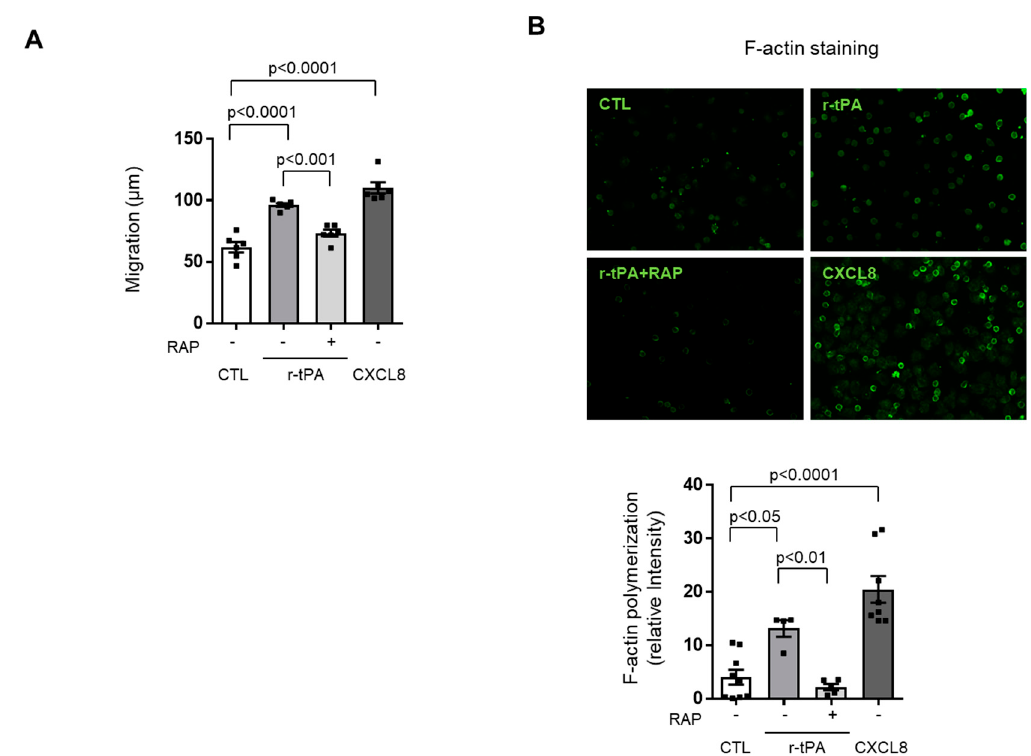
Figure 3. Pre-treatment with receptor-associated protein (RAP) inhibits neutrophils migration and F-actin polymerization towards recombinant tissue plasminogen activator (r-tPA). ( A ) Human neutrophils were pre-treated for 1 h with control medium (CTL) or 0.5 µM RAP and tested for their chemotactic response to 0.03 mg/mL r-tPA and 1nM CXCL8 as positive control. Data are expressed as mean of migration distance (µm) ± 1 SEM in the nitrocellulose assay, n = 6. ( B ) F-actin content in neutrophils: tests were performed under the same experimental conditions as abovementioned. Representative pictures showing F-actin stained in green and quantification of the images. Data are expressed as relative intensities (mean ± 1 SEM), n =